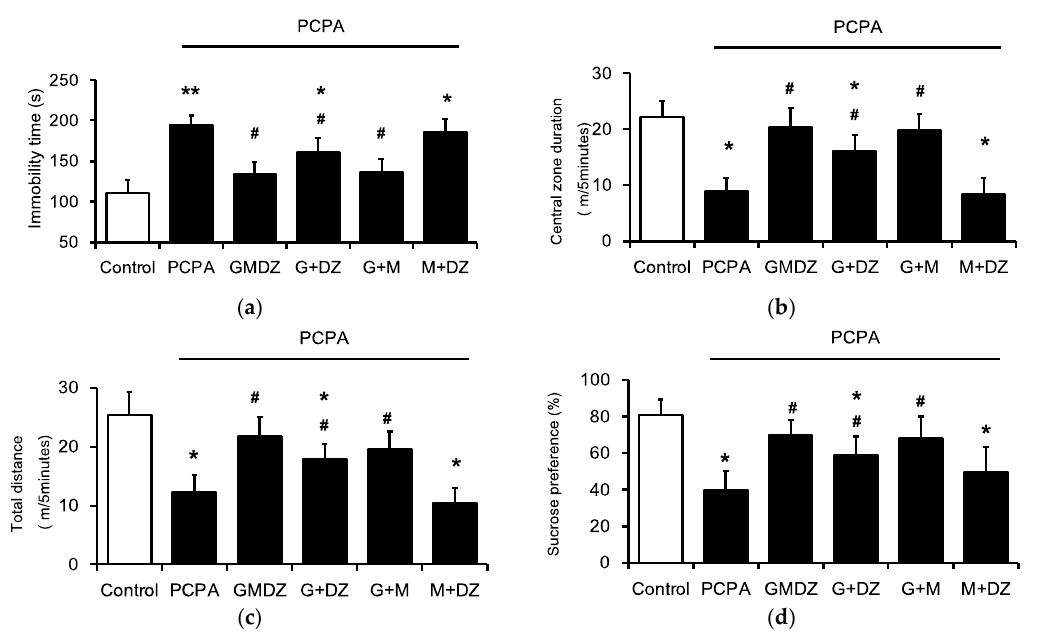
Figure 2. Effects of the one herb-deleted mixture of GMDZ in depression-like behaviors using the PCPA treated rats. ( a ) The changes of immobility time in FST; ( b ) the changes of time in central in OFT; ( c ) the changes of traveling distance in OFT; ( d ) the changes of sucrose solution consumption (%) in SPT. Data are expressed as mean ± SE ( n = 8). * p < 0.05, ** p < 0.01 compared with the normal control; # p < 0.05 compared with vehicle-treated group.